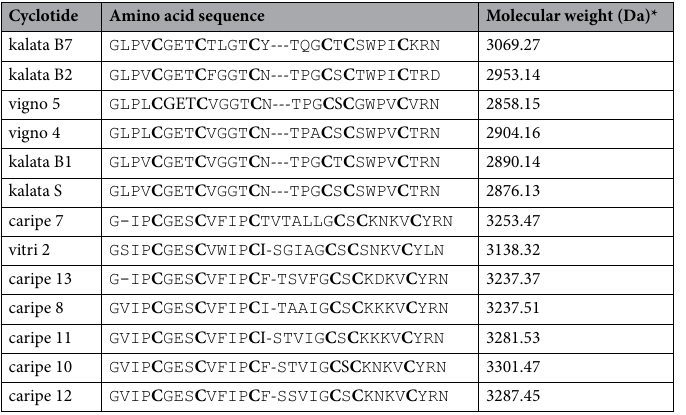
Table 1. Sequence alignment and molecular weight of cyclotides analyzed in plant extracts from O. affinis , V. tricolor , and C. ipecacuanha. *Molecular weight is provided as monoisotopic mass taken from CyBase 55 .